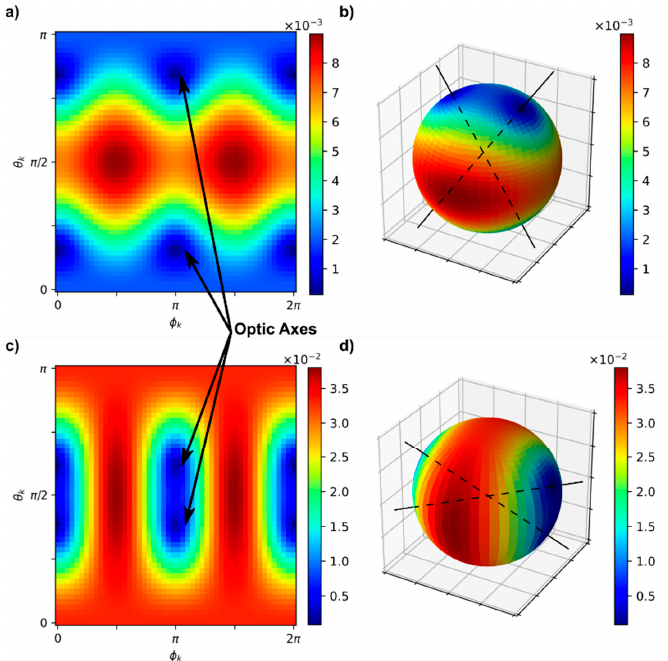
Figure 3. Calculation of intrinsic birefringence by subtraction of indicatrix projection ellipse semi- major axes from each other as a function of θ k & φ k . Distributions are shown in 2D (left) and 3D spherical (right) projections for a topaz crystal ( a , b ) with refractive indices of n 1 = 1.618, n 2 = 1.620, and n 3 = 1.627 and muscovite ( c , d ) crystal with indices n 1 = 1.563, n 2 = 1.596, and n 3 = 1.601. Maxima denote areas of high birefringence while the minima correspond to points where the refractive indices are equal and hence an optic axis. The small differences in refractive index cause a significant difference in separation of the optic axes as seen in the 3D projections (black lines). An example of a uniaxial crystal is shown in the Supplementary